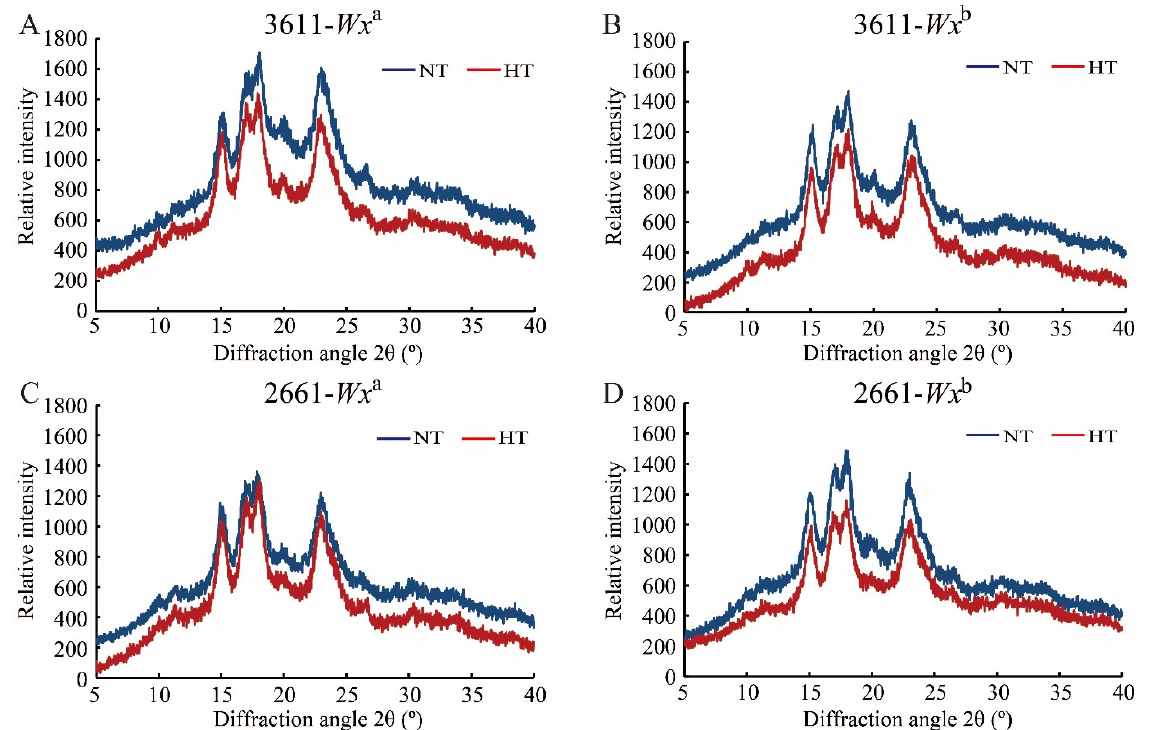
Figure 8. XRD spectra of different Wx NILs starches with 3611 ( A , B ) and 2661 ( C , D ) genetic backgrounds under different temperature conditions. “NT” stands for normal condition and “HT” stands for high-temperature condition.